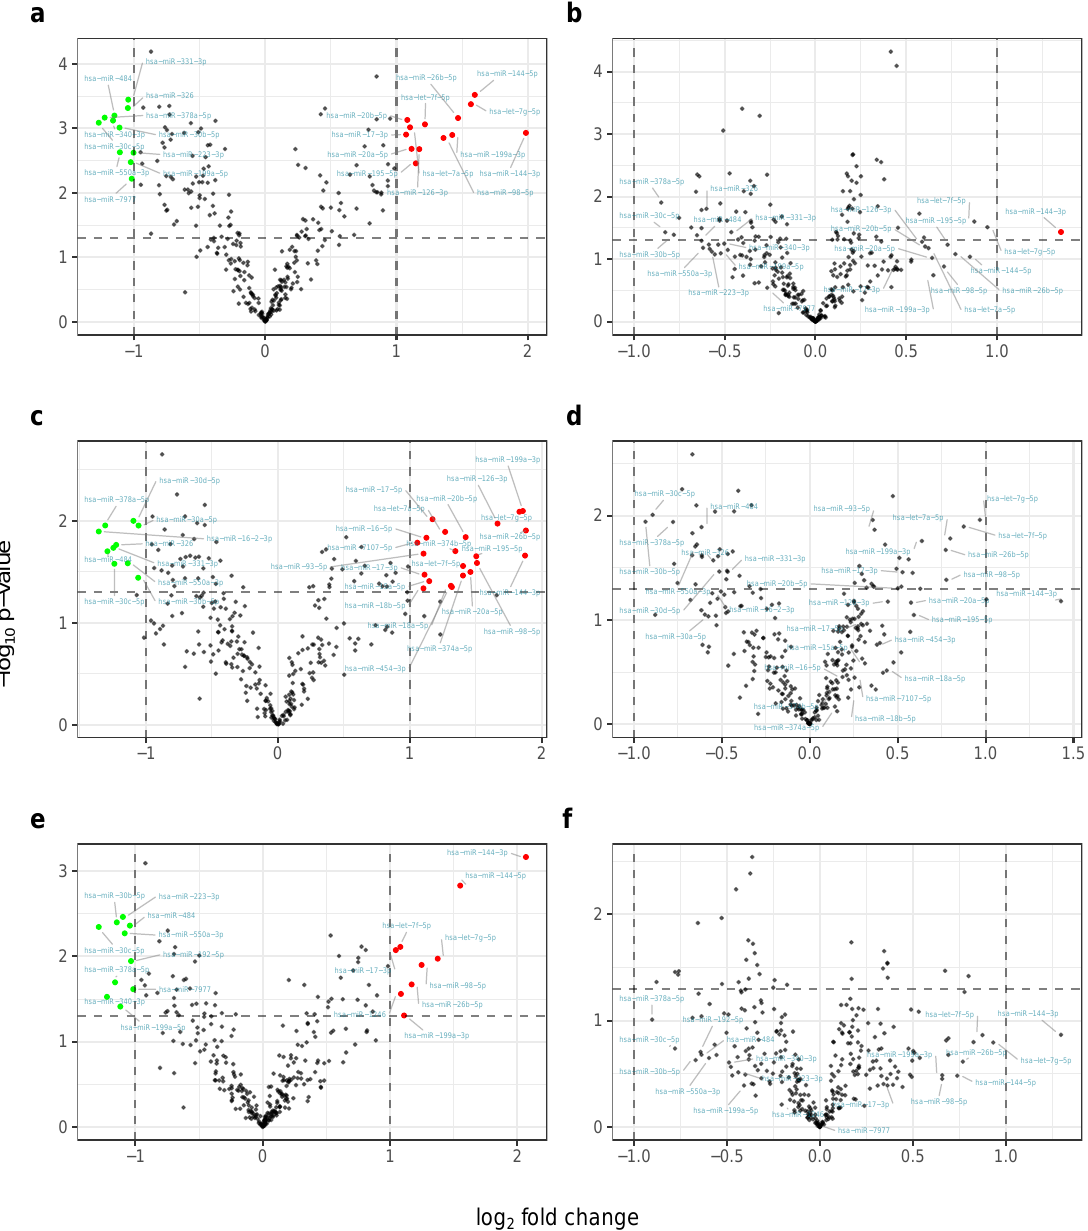
Figure 3. Volcano plots for six comparison setups using 307 microRNAs. The x -axis indicates log 2 fold change, while the y -axis refers to the negative decade logarithm of p -values from student’s t-tests (unadjusted). Dashed horizontal lines indicate a p -value of 0.05, while dashed vertical lines indicate a log 2 fold change of 2. ( a ) Pooling the samples from the two participant groups and using timepoints of the first training interval ( E 1 and A 1 ); ( b ) pooled sample approach analogous to ( a ) but with timepoints from the second training period ( E 2 and A 2 ); ( c ) analysis for timepoints like in ( a ) only using samples from the first treatment group; ( d ) analysis for timepoints like in ( b ) only using samples from the first treatment group; ( e ) analysis for timepoints like in ( a ) only using samples from the second treatment group; ( f ) Analysis for timepoints like in ( b ) only using samples from the second treatment group. MiRNAs that exceed both axis thresholds (dashed lines) are colored according to their direction of dys-regulation, i.e., red for up-regulation and green for down-regulation after training. For each row of panels, significantly de-regulated miRNAs on the left side (panels ( a , c , e ) are labelled and displayed on the corresponding right side (panels b , d , f